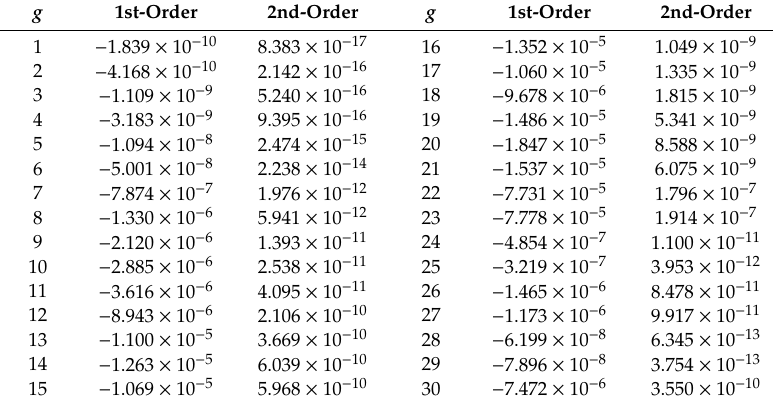
Table 22. Comparison of 1st-order relative sensitivities and 2nd-order relative sensitivities cross sections for isotope 4 ( 71